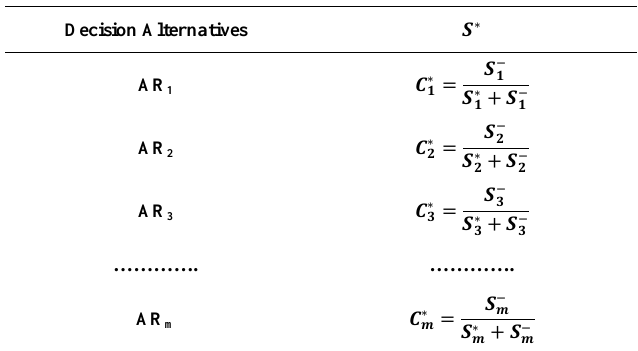
Table 1. Decision alternatives and relative distance measure.